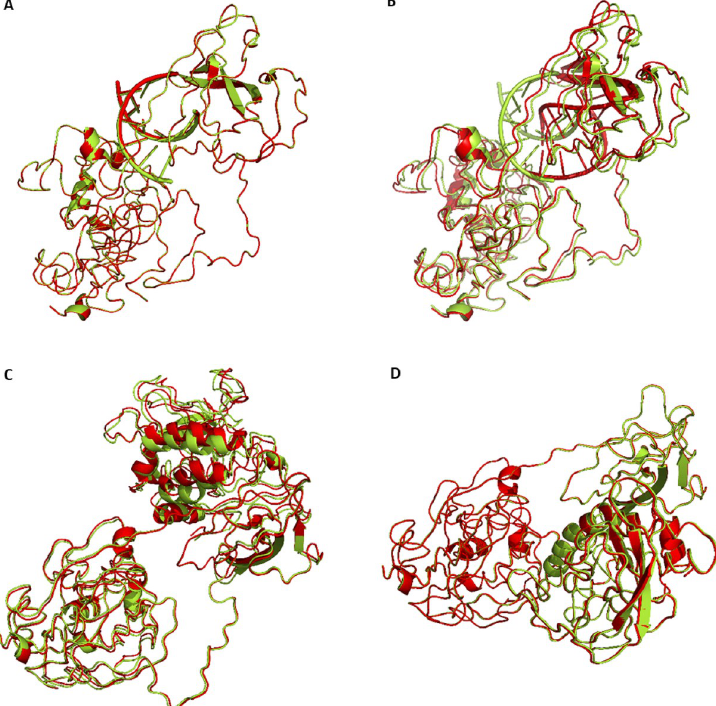
Fig 7. Aligned tertiary and quaternary structural predictions of the complex between the Nucleocapsid (N) protein and RNA (PDB ID: 4U37). A. Protein-RNA HDOCK docking simulations’ result. B. Protein-RNA MPRDock docking simulations’ results. REF-P13L complexes colored in red, ALT-P13L complexes colored in green. C. Protein- protein ClusPro docking simulations’ result of aligned tertiary and quaternary structural predictions of the complex between the Nucleocapsid (N) protein and membrane (M) proteins. D. The same analysis shown in panel C performed using protein-protein HDOCK docking simulations. REF-P13L complexes colored in red; ALT-P13L complexes colored in